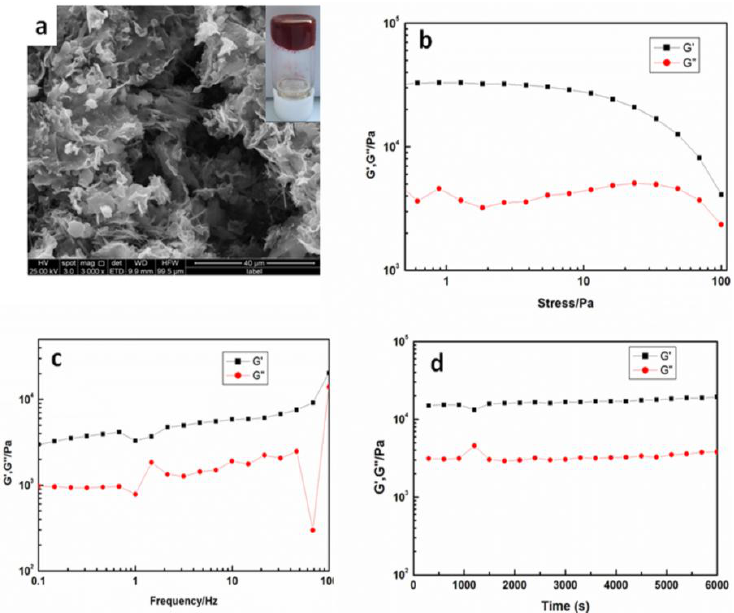
Figure 3. ( a ) SEM images of the xerogels for NAPD/MM/RF/NMD hydrogel ([NAPD] = 5 g/L, [NMD] = 10 g/L) (Insert: Photo of the gel); ( b ) Strain sweep for NAPD/RF/MM/NMD gel at above concentration; ( c ) Frequency sweep of the NAPD/RF/MM/Drugs gel at the strain of 0.1%; ( d ) Time sweep of the NAPD/RF/MM/NMD gel at the strain of 30%.